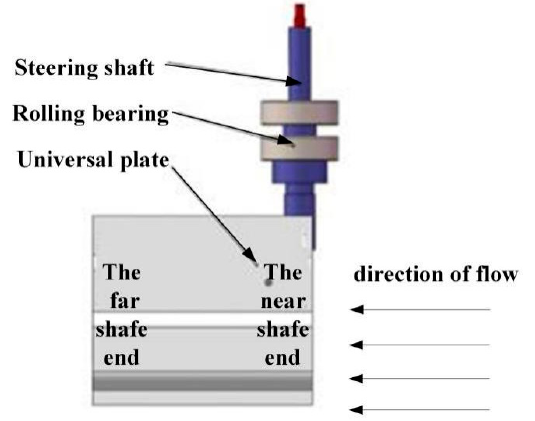
Figure 8. The universal plate of Sensor adaptive water flow.